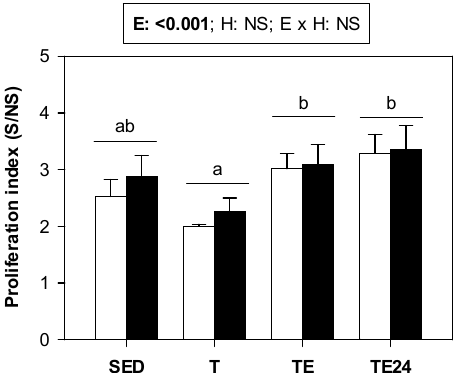
Figure 6. Proliferative activity of MLNs. The non-supplemented groups are represented by white bars and the hesperidin-supplemented groups by black bars. SED = sedentary groups; T = trained groups; TE = T groups with an additional exhaustion test; TE24 = TE groups 24 h after the exhaustion test. E = exercise; H: hesperidin supplementation; E × H = interaction between E and H; NS = no significant differences. Data are expressed as mean ± SEM ( n = 8). Statistical analysis (ART-ANOVA test): Different letters indicate significant differences due to exercise.